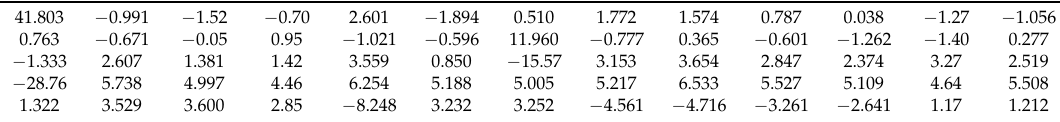
Table 10. The input weight values of the